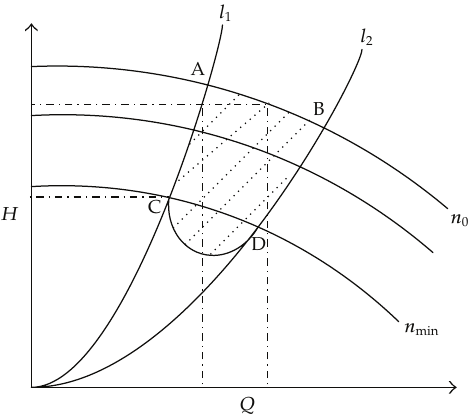
Figure 6: E ffi cient operation area for the variable-speed